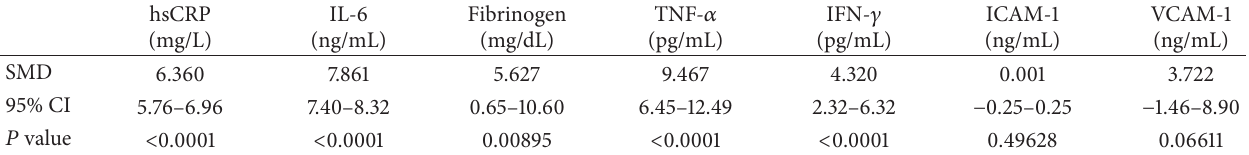
Table 3: Summary of SMDs and 95% CI of inflammatory marker levels in case-control analysis.